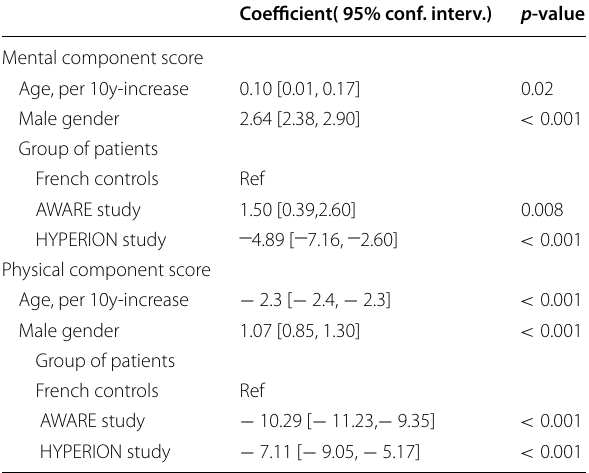
Table 2 Results of HRQOL interview at day‑90. Data are shown as median [interquartile] and compared using a Kruskal‑Wallis